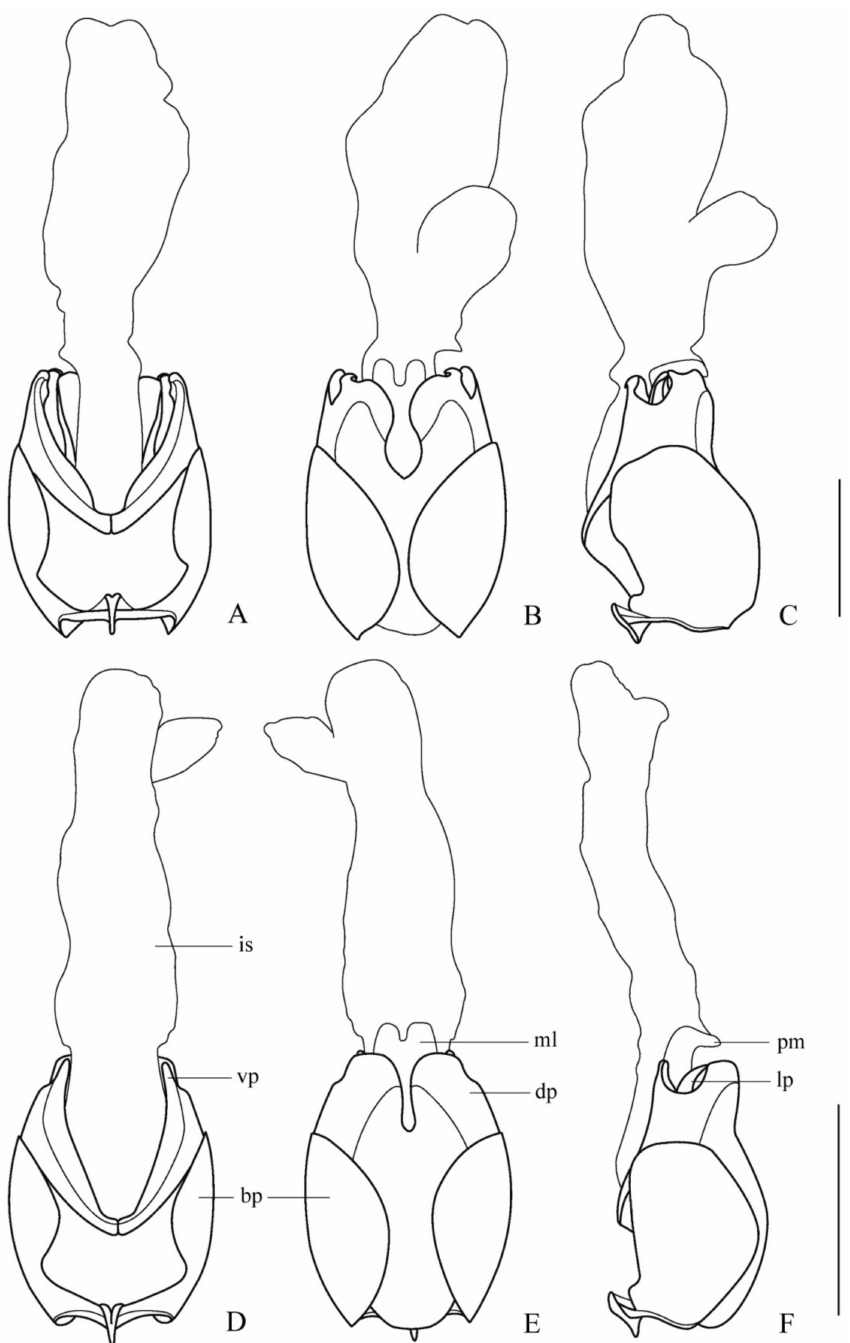
Figure 2. Aedeagus ( A , D ). ventral view; ( B , E ) dorsal view; ( C , F ) lateral view): ( A – C ) Lycocerus binotatus sp. nov. ; ( D – F ) L. testacicollis sp. nov. Scale bars: 1.0